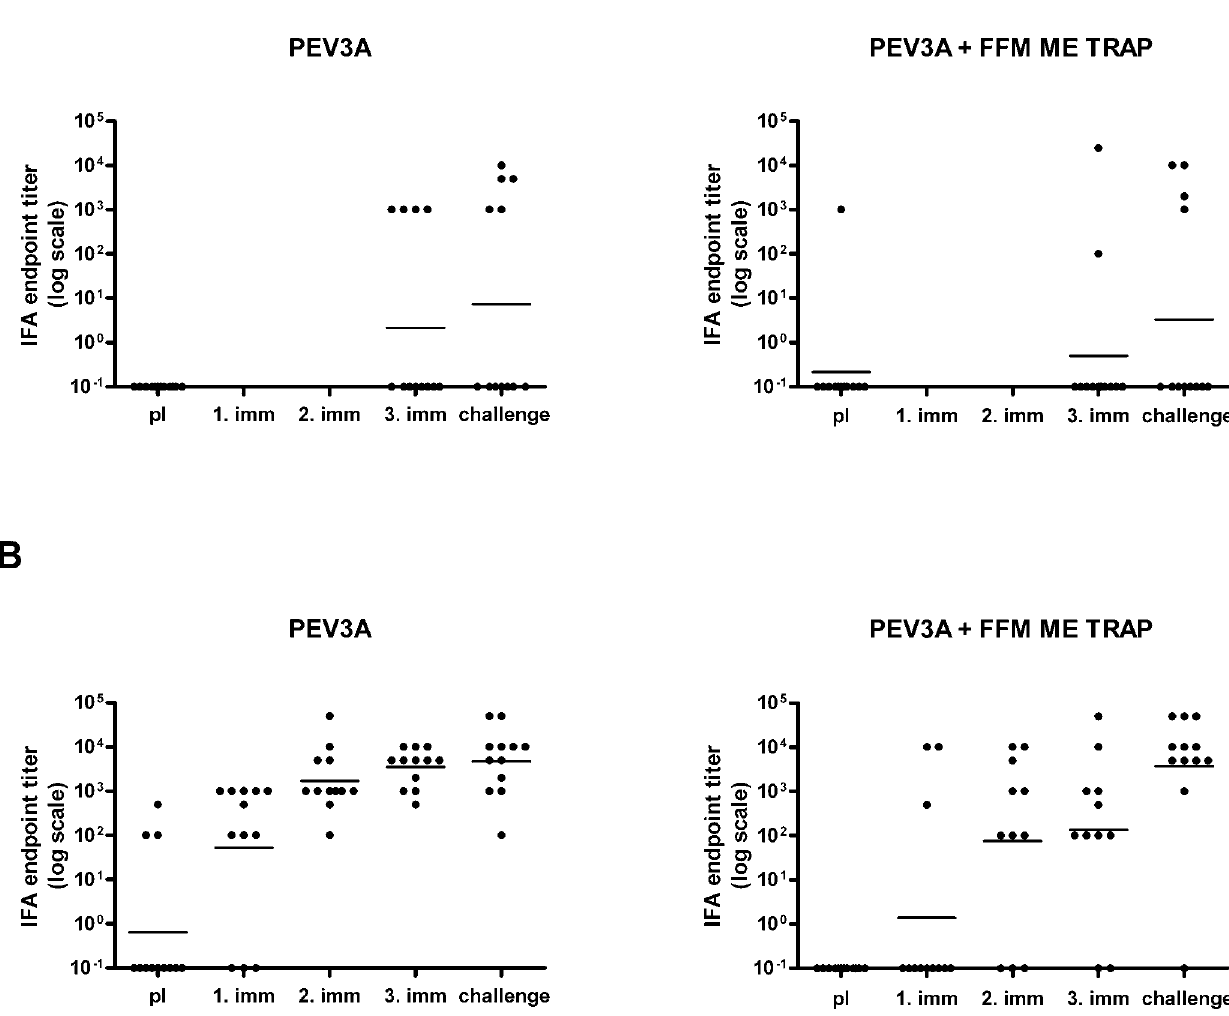
Figure 4. Antibody reactivity with P.falciparum. A. (Upper panel) IgG endpoint titres measured in IFA with P. falciparum (K1) blood stage parasites. B. (Lower panel) IgG endpoint titres measured in IFA with P. falciparum (NF54) sporozoites. Sera were tested before vaccination, after every vaccination and after sporozoite challenge. Individual titres and the geometric mean for every time point are shown on a log scale.